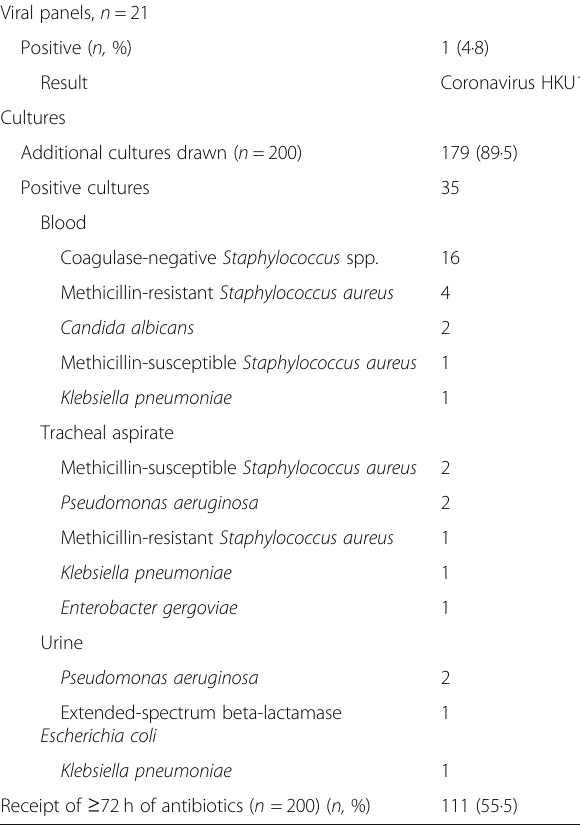
Table 6 Culture data and antibiotic management Viral panels, n = 21